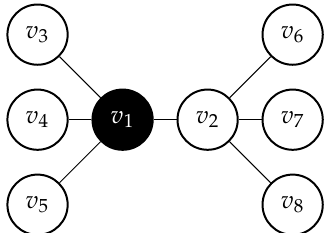
Figure 3. Example problem instance after the first step of generating a solution. Let us assume that the capacity of each node is 4. Vertex v 1 was chosen in the first step. As the capacity of v 1 is 4, all its neighbors are placed in C ( v 1 ) and covered by v 1